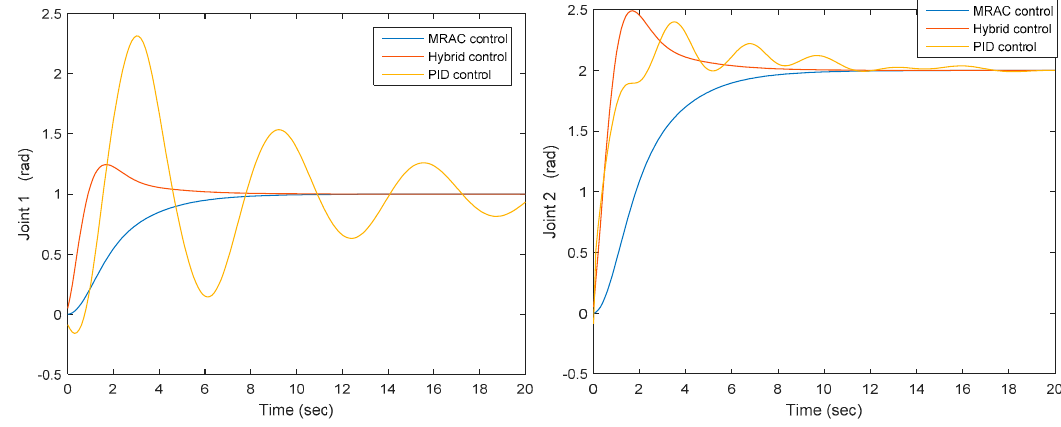
Figure 14. Joints’ 1 and 2 outputs under three controls.